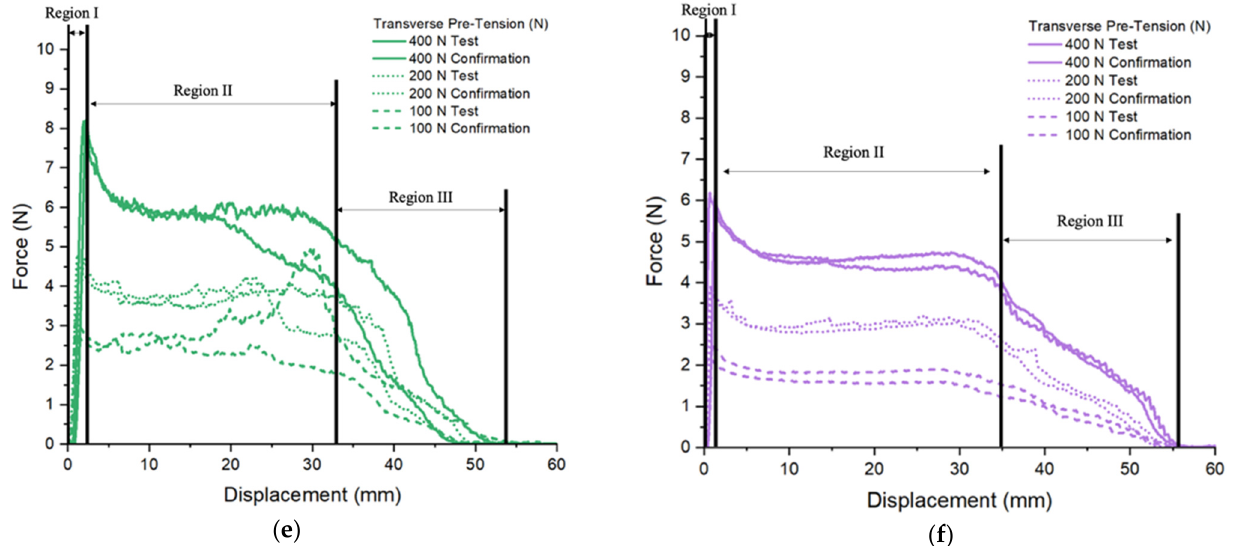
Figure 9. Yarn pull-out force–displacement response of control and metal-coated groups. ( a ) Control (tail length—20.63 mm; woven length—28.60 mm); ( b ) Aluminum (tail length—15.82 mm; woven length—31.50 mm); ( c ) Copper (tail length—28 mm; woven length—27.00 mm); ( d ) Silver (tail length—22.22 mm; woven length—31.75 mm); ( e ) Al/AlN (tail length—20.00 mm; woven length—36.00 mm); ( f ) Hybrid Al/Control (tail length—23.27 mm; woven length—32.50 mm).